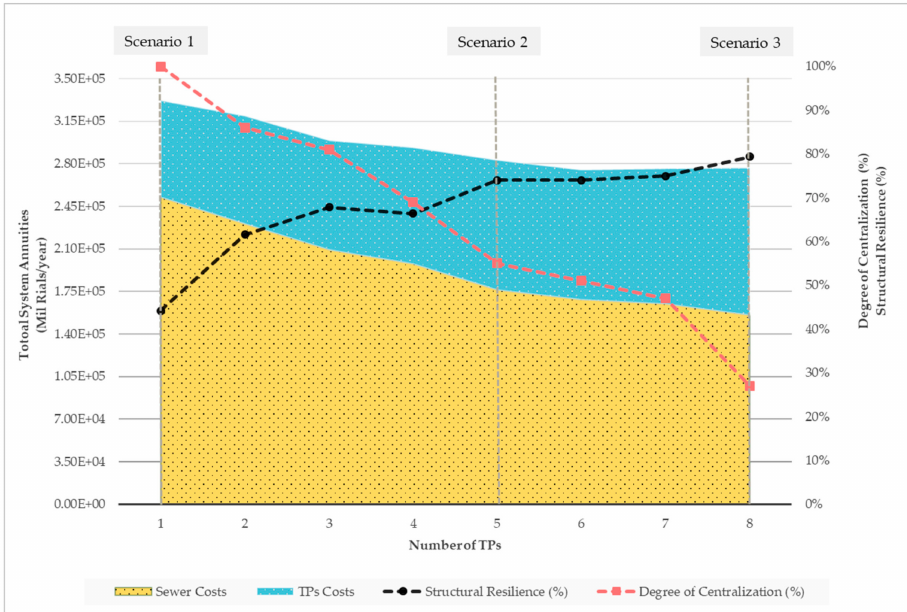
Figure 10. Selected solutions from the Pareto front for different numbers of treatment plants.